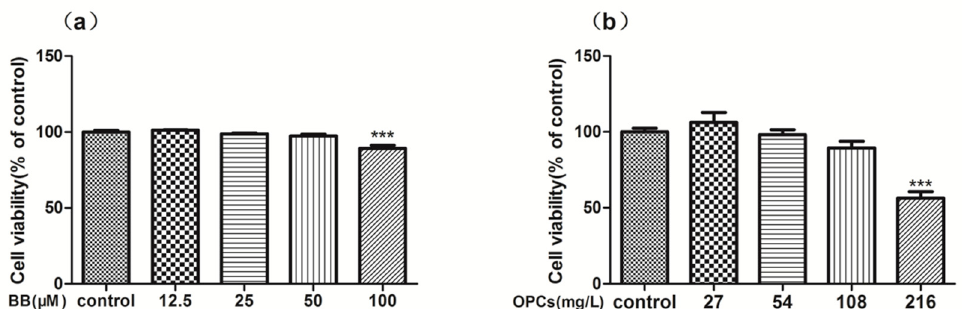
Figure 4. Cytotoxicity and reversing activity of BB and OPCs by MTT assay in Caco-2 cells. Cells were treated with various concentrations of BB ( a ) and OPCs ( b ) for 24 h for toxic determination. Data are presented as mean ± SEM of three independent experiments. *** p < 0.001 vs. control.